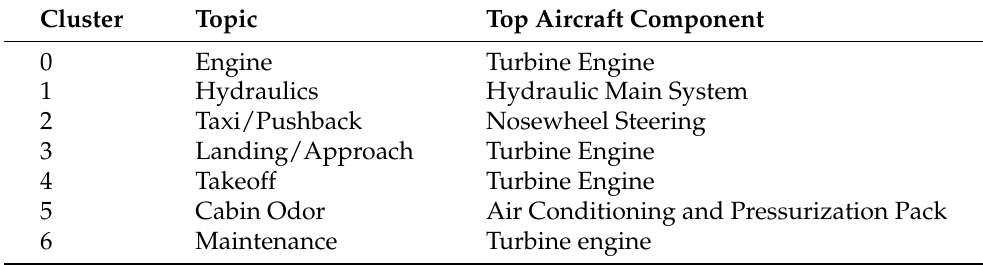
Table 2. Most frequently associated aircraft component metadata for each major